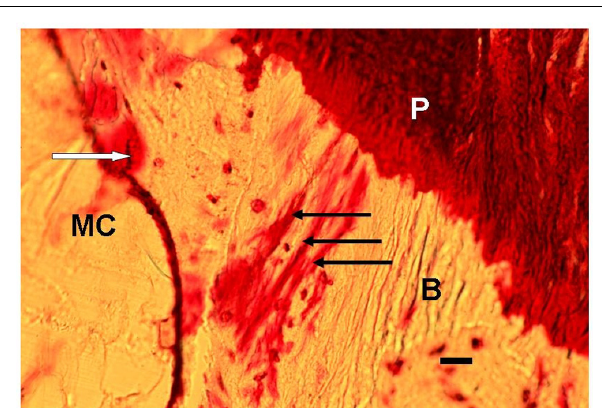
FIGURE 1 | Photomicrograph of a typical representative array of three periosteal Sharpey’s fibers (black arrows), each about 15 μ m thick, and extending from the periosteum (P), through the bone (B) toward the endosteum outside which is the marrow cavity (MC). In addition, nearby are stress-induced microcracks, for example, one (white arrow) is surrounded by bone matrix which has become “leaky” to the stain (normally impervious) apparently due to submicroscopic fatigue fissures increasing accessibility of the dye. Human proximal femur. En bloc gentian violet stain. Scale bar 30 μ m.